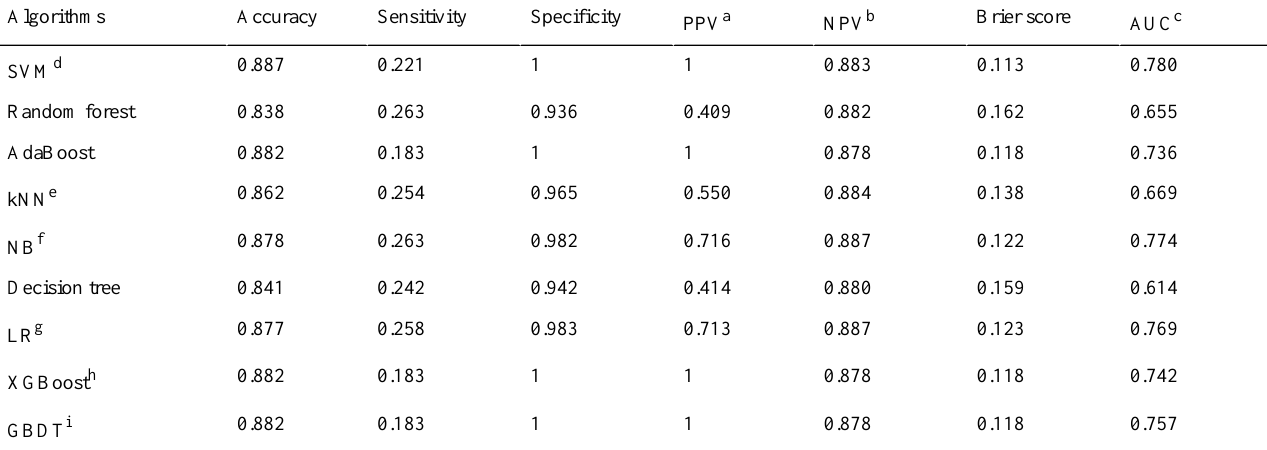
Table 3. The detection performance of 9 algorithms for the external validation dataset.